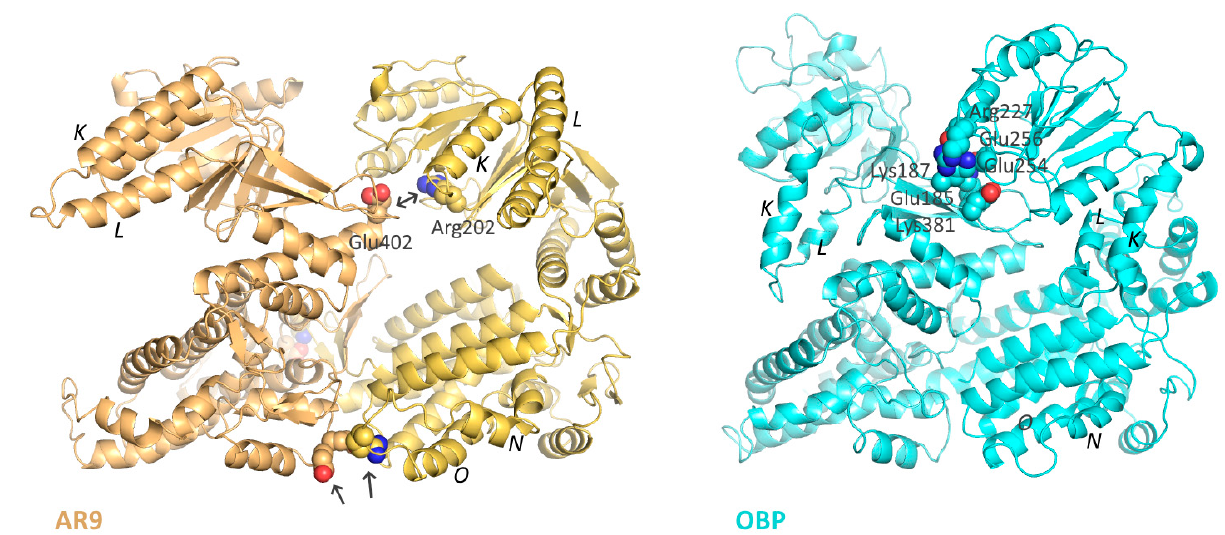
Figure 3. Inter-subunit contacts in the apo-form of the AR9 chaperonin ( left ) and the OBP chaperonin ( right ). Arrows show important inter-subunit salt bridges; the helices K, L, N, O and the key Arg202-Glu402 pair are labeled.